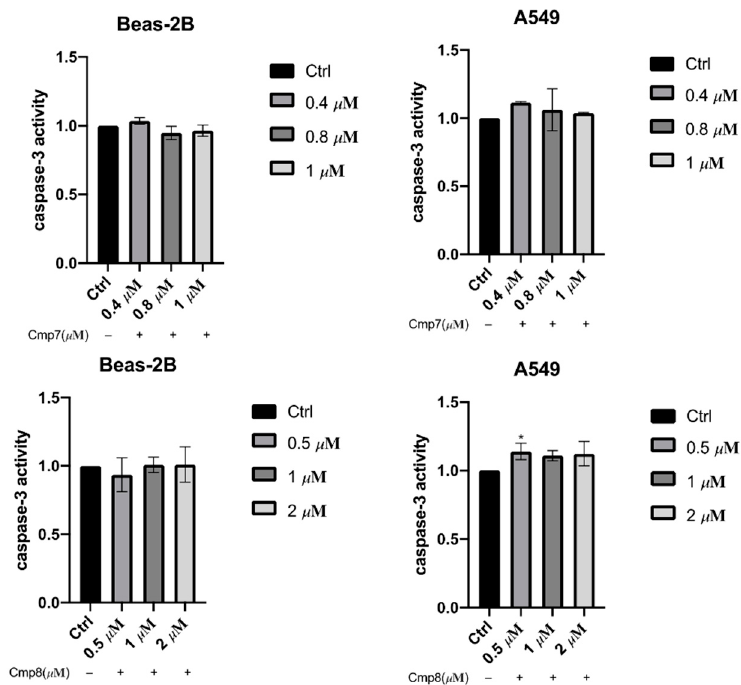
Figure 6. Fluorometric determination of caspase-3 activation for endoperoxides 7 and 8 using Ac- DEVD-pNA. The caspase-3 activation index of the control group was set as 1.0. Data points for caspase-3 activity represent the means of triplicate determinations ± S.D. By t-test analysis, * p < 0.05, compared to the control group.